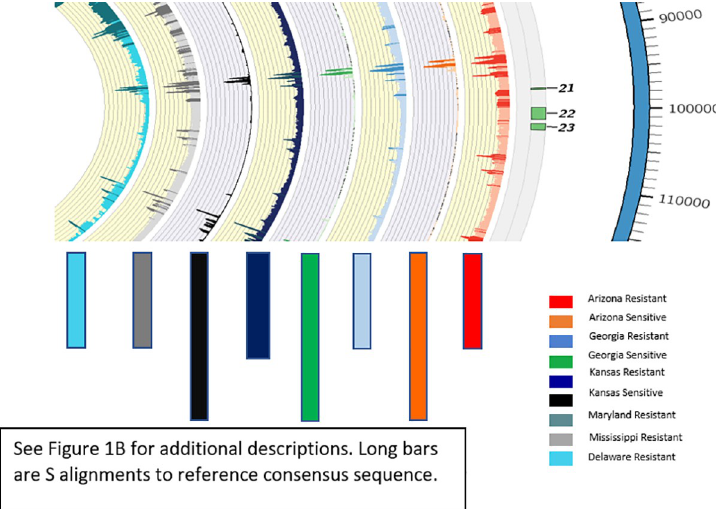
Fig 4. Enlarged segment of Fig 3. From left to right, short arrows point to color matched read depths of GR plants from Delaware (DE-R), Maryland (MD-R), Kansas (KS-R), Georgia (GA-R), and Arizona (AZ-R aligned to the Mississippi reference assembly and long arrows point to color matched read depth of GS plants from Kansas (KS-S), Georgia (GA_S) and Arizona (AZ_S) alignments. https://doi.org/10.1371/journal.pone.0233813.g004 filtering for concordant pair alignments and quality (Q > 20, Table 1). Each GR biotype mapped at least 2.2 M read pairs, with greater than 92% aligning in proper pairs (Fig 1). Con- versely, the WGS reads derived from GS biotypes had less than 200 k high quality aligned pairs, where 50% or less were in the proper orientation (Figs 3 and 4). Average read mapping depths of GS biotype sequences to the replicon varied by a magnitude of 5. All GR biotypes had at least 1,000 reads mapped when averaged; while all GS biotypes had no more than 181 reads as an average depth (S1 Table). When Illumina data from GS biotypes was aligned to the